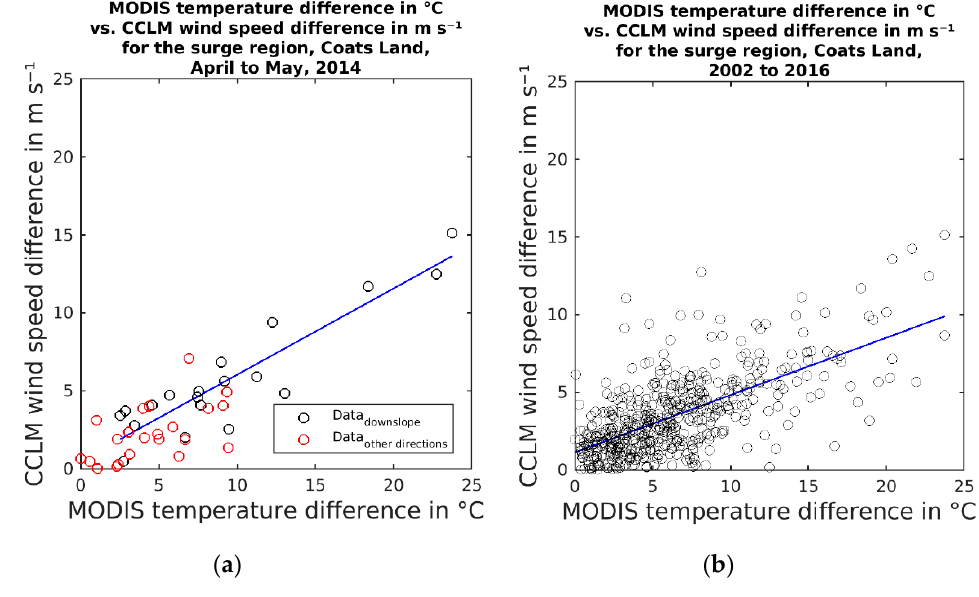
Figure 15. IST difference between surge area and reference area and corresponding CCLM 10 m-wind speed difference for ( a ) April and May 2014 for all days (red symbols) and days with the downslope wind (black symbols) and ( b ) winters 2002–2016 for the days with the downslope wind. The blue line indicates the linear fit.